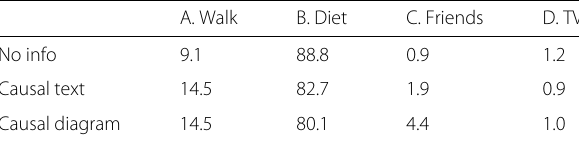
Table 1 Percentage of respondents selecting each option across the three conditions in Experiment